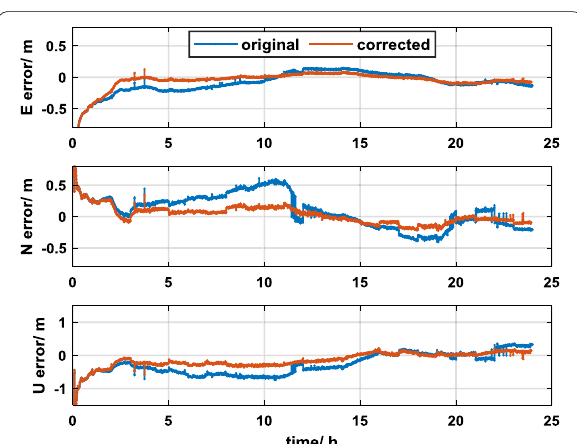
Fig. 6 Positioning results with (corrected) and without (original) the fluctuation correction